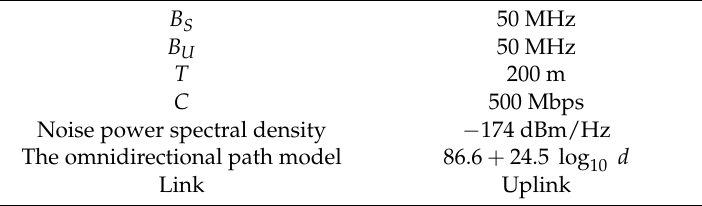
Table 1. Simulation Parameter for Location of UAV (LU)